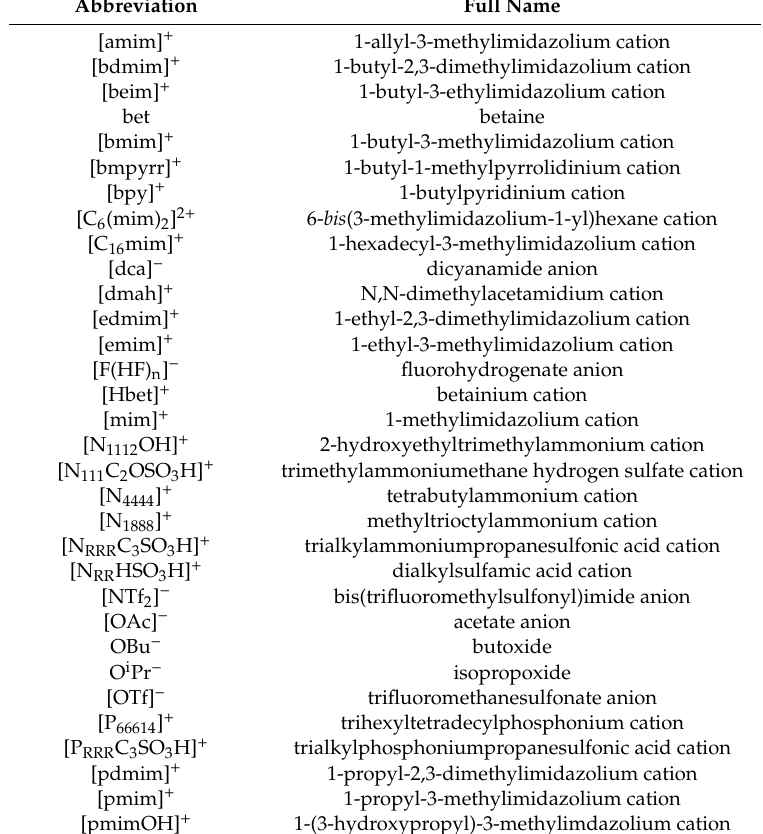
Table 1. Synopsis of used abbreviations of cations and anions of Ionic liquids (ILs) as well as other reagents in the